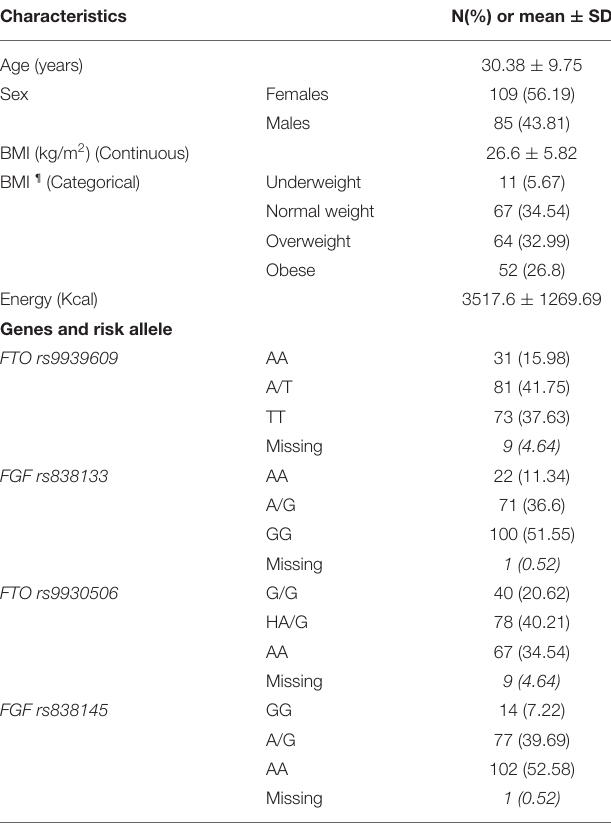
TABLE 1 | Descriptive characteristics of the study population ( n = 194).